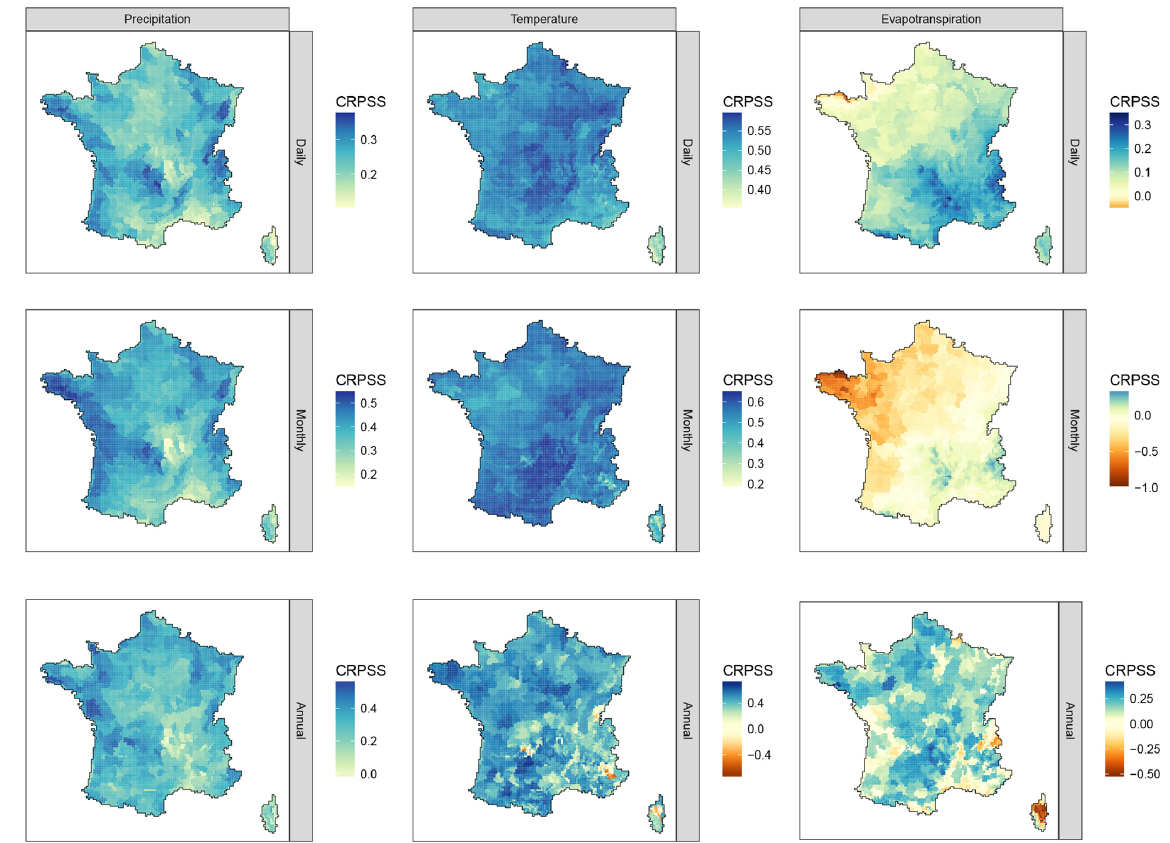
Figure 11. Daily, monthly, and annual CRPSS between SCOPE Climate and Safran for precipitation, temperature, and reference evapotran- spiration over the 1959–2007 period. Note the different scales across the maps.